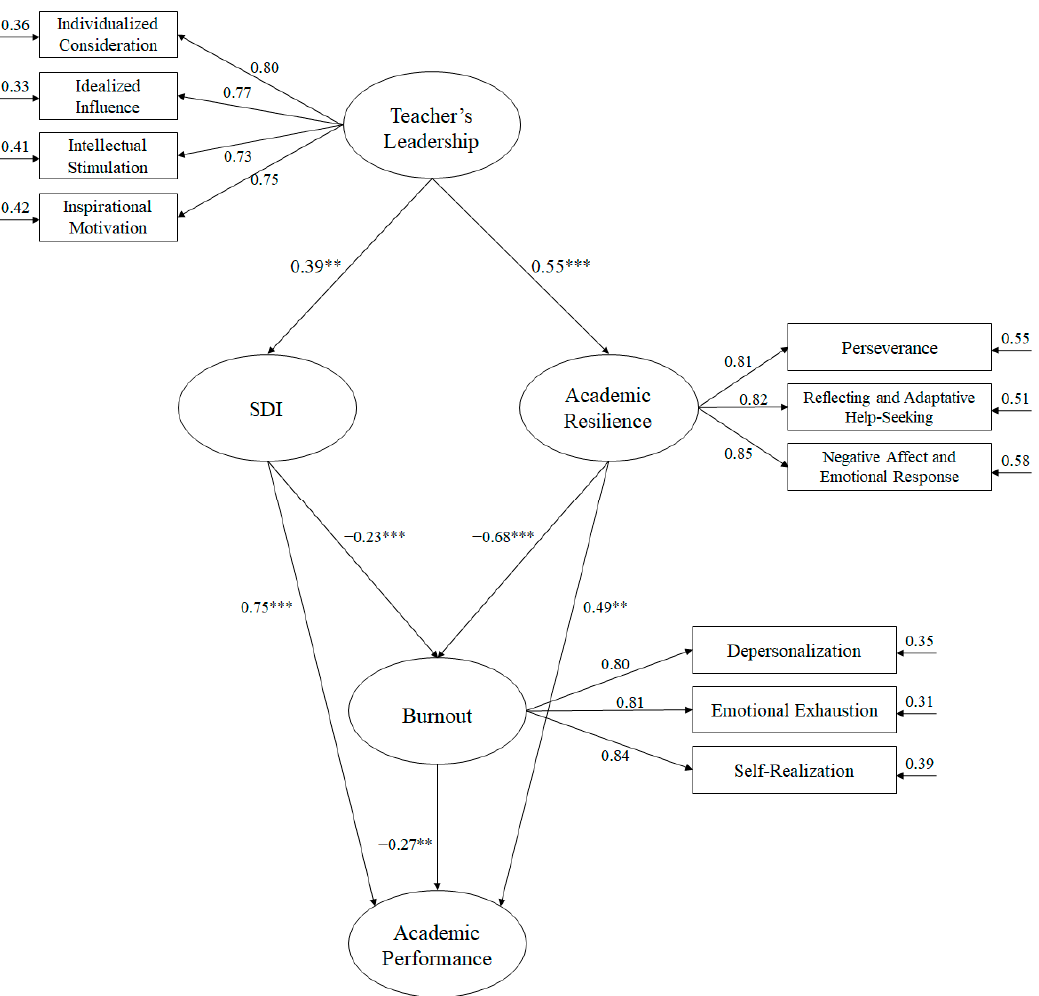
Figure 1. Hypothesized model, where all variables are related to one another. All parameters are standardized and are statistically significant. Note: *** p < 0.001;** p < 0.01.